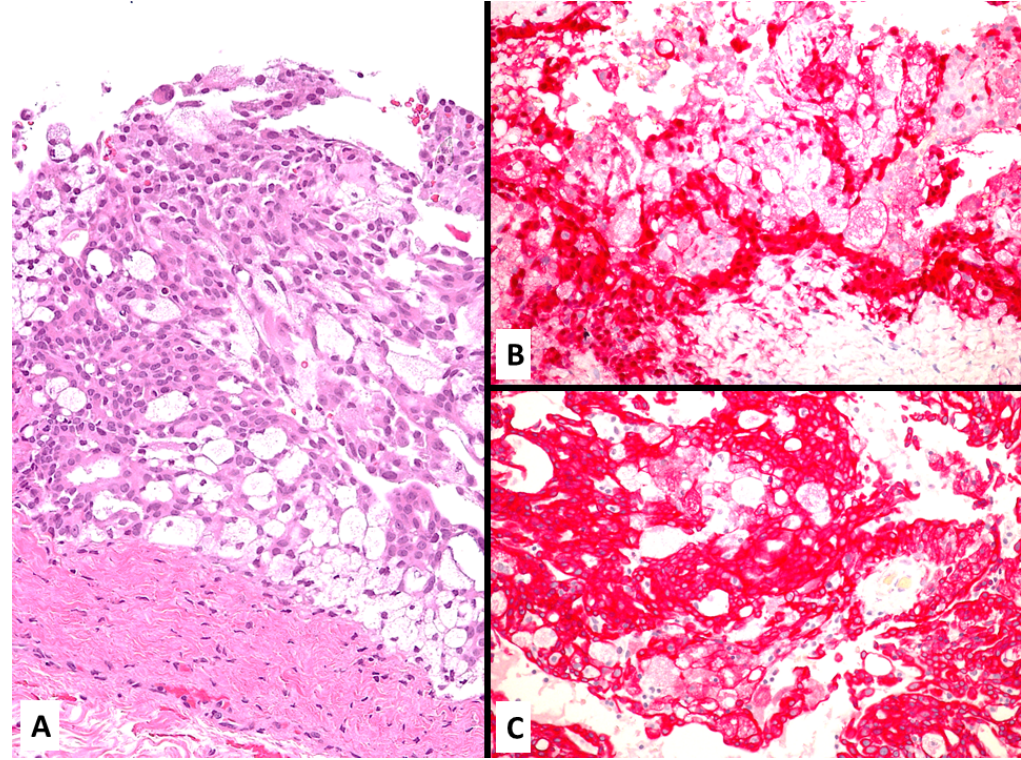
Figure 10. Clear cell malignant mesothelioma with proliferation of large-sized cells with foamy cytoplasm ( A ) strongly staining with calretinin ( B ) aberrantly expressing CK20 ( C ).